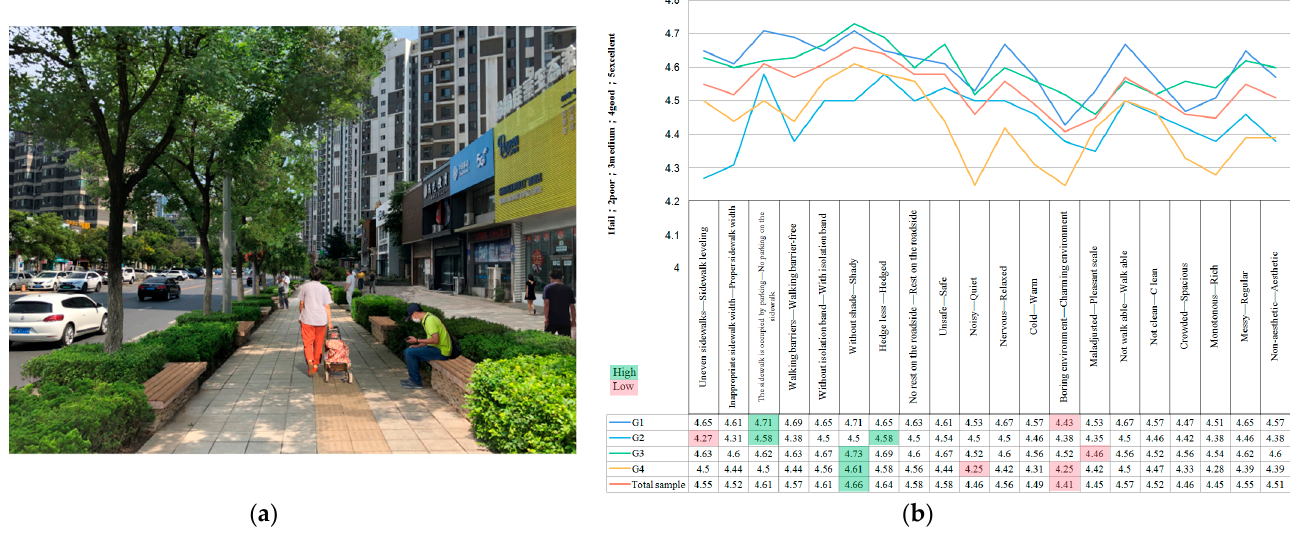
Figure 2. ( a ) Street environment after intervention (manipulated photos); ( b ) SD analysis method—4 subgroups and total sample street environment post-intervention evaluation